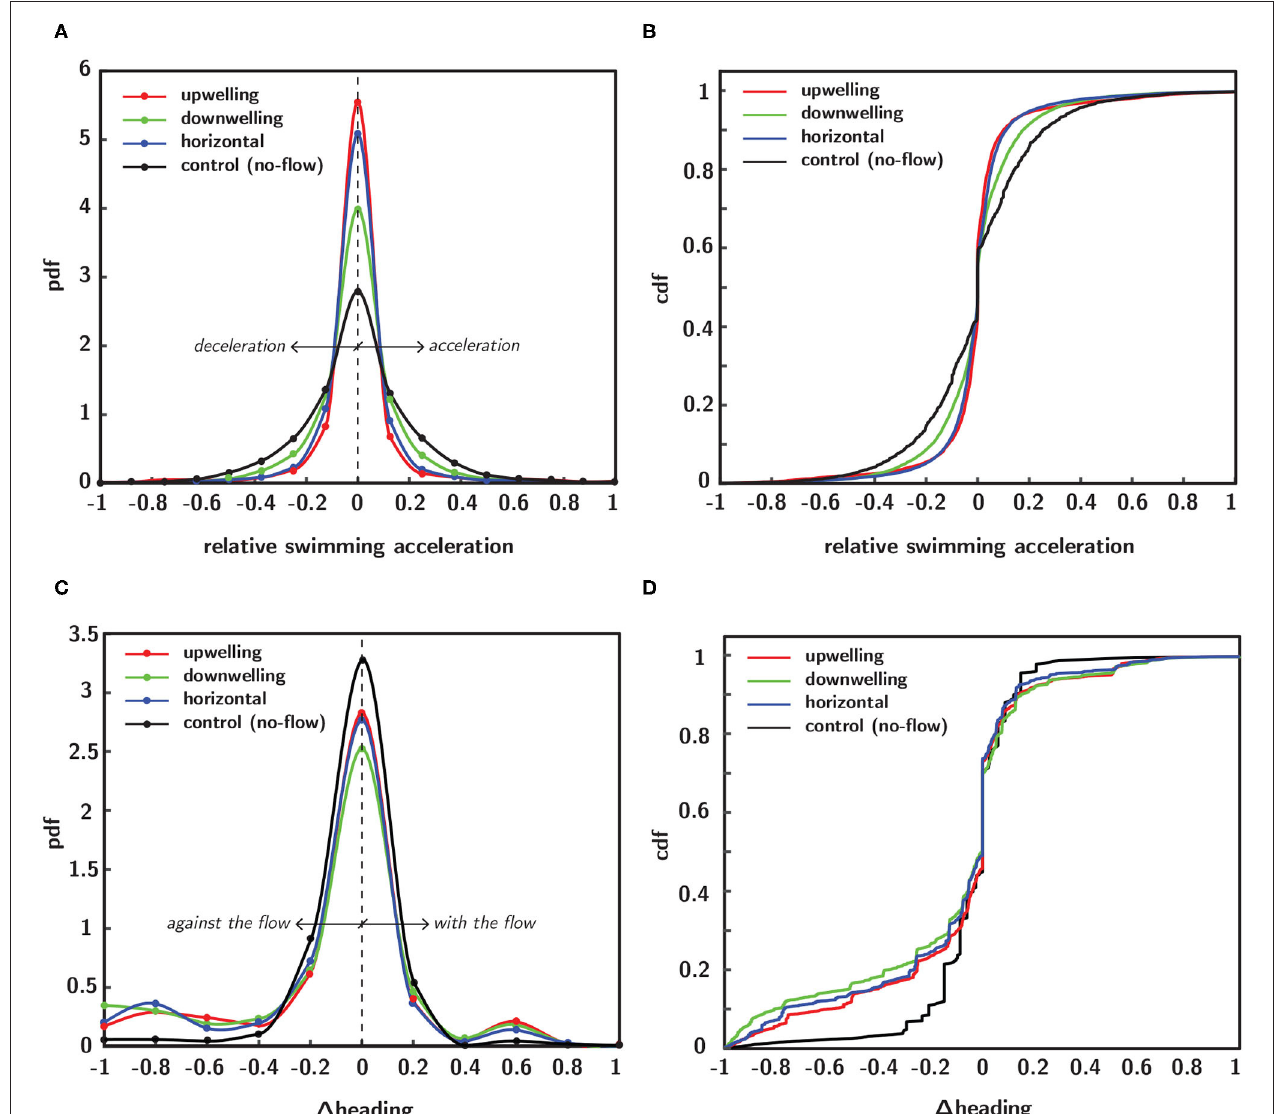
FIGURE 9 | Empirical probability (pdf) and cumulative (cdf) distribution functions of normalized swimming kinematics in different flow configurations, including no-flow (black), upwelling (red), downwelling (green) and horizontal (blue) shear flows. Pdfs of normalized relative swimming acceleration (A) and corresponding cdfs (B) . Pdfs of normalized change in directional heading (C) and corresponding cdfs (D)